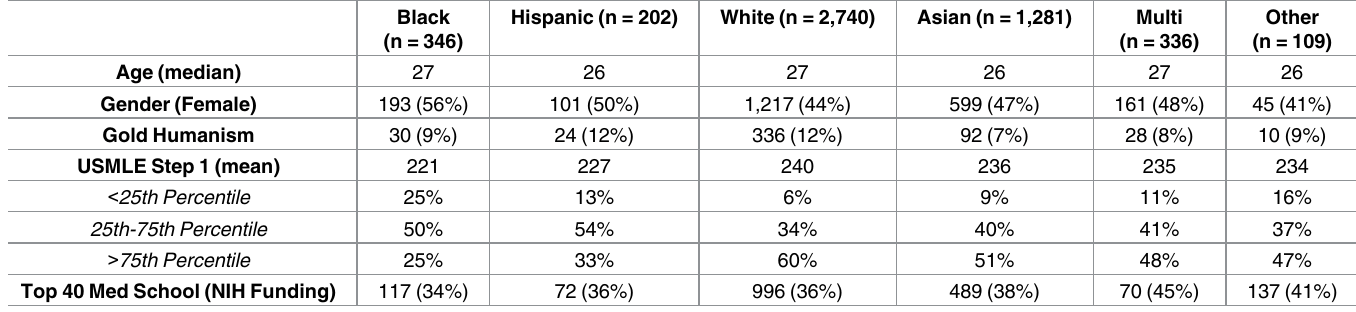
Table 2. Population demographic